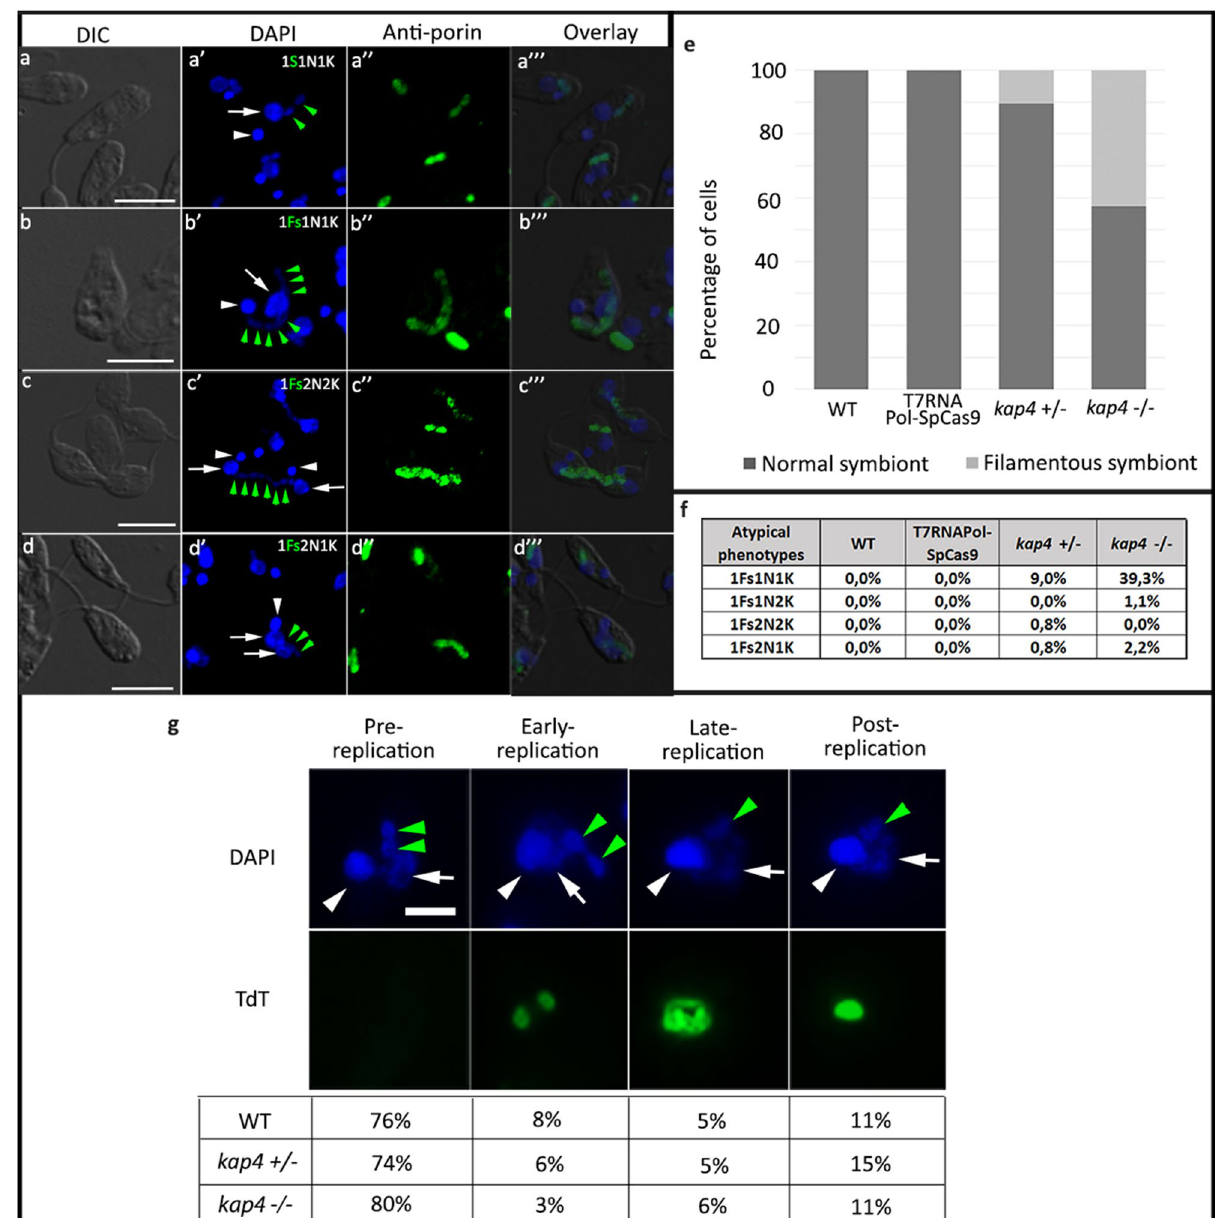
Figure 3. Atypical phenotypes were observed in KAP4 mutant cells cultivated for 24 h after labeling with DAPI and anti-porin antibodies. WT ( a – a ″ ); kap4 +⁄− mutants containing one filamentous symbiont with multiple nucleoids (Fs—green arrowhead), one nucleus (N-white arrows) and one kinetoplast (K-white arrowhead) ( b – b ″ ) or two nuclei and two kinetoplasts and ( c – c ″ ); kap4 −⁄− cells were seen with one filamentous symbiont, two nuclei and one kinetoplast ( d – d ″ ). Bars 5 μm. ( e ) Counting of cellular patterns showing that filamentous symbionts (Fs) are more frequent in kap4 −⁄− . ( f ) Percentage of cells presenting atypical phenotypes. ( g ) In situ labeling showing the different stages of kDNA network replication in WT and mutant cells (according to Liu and Englund 2007) 15 . Green arrowheads indicate the symbiont, white arrows the nucleus and white arrowheads the kinetoplast. Bars 1 μm. t test p-value < 0.005. A total of 1000 WT and KAP4 mutant cells were counted in 3 independent